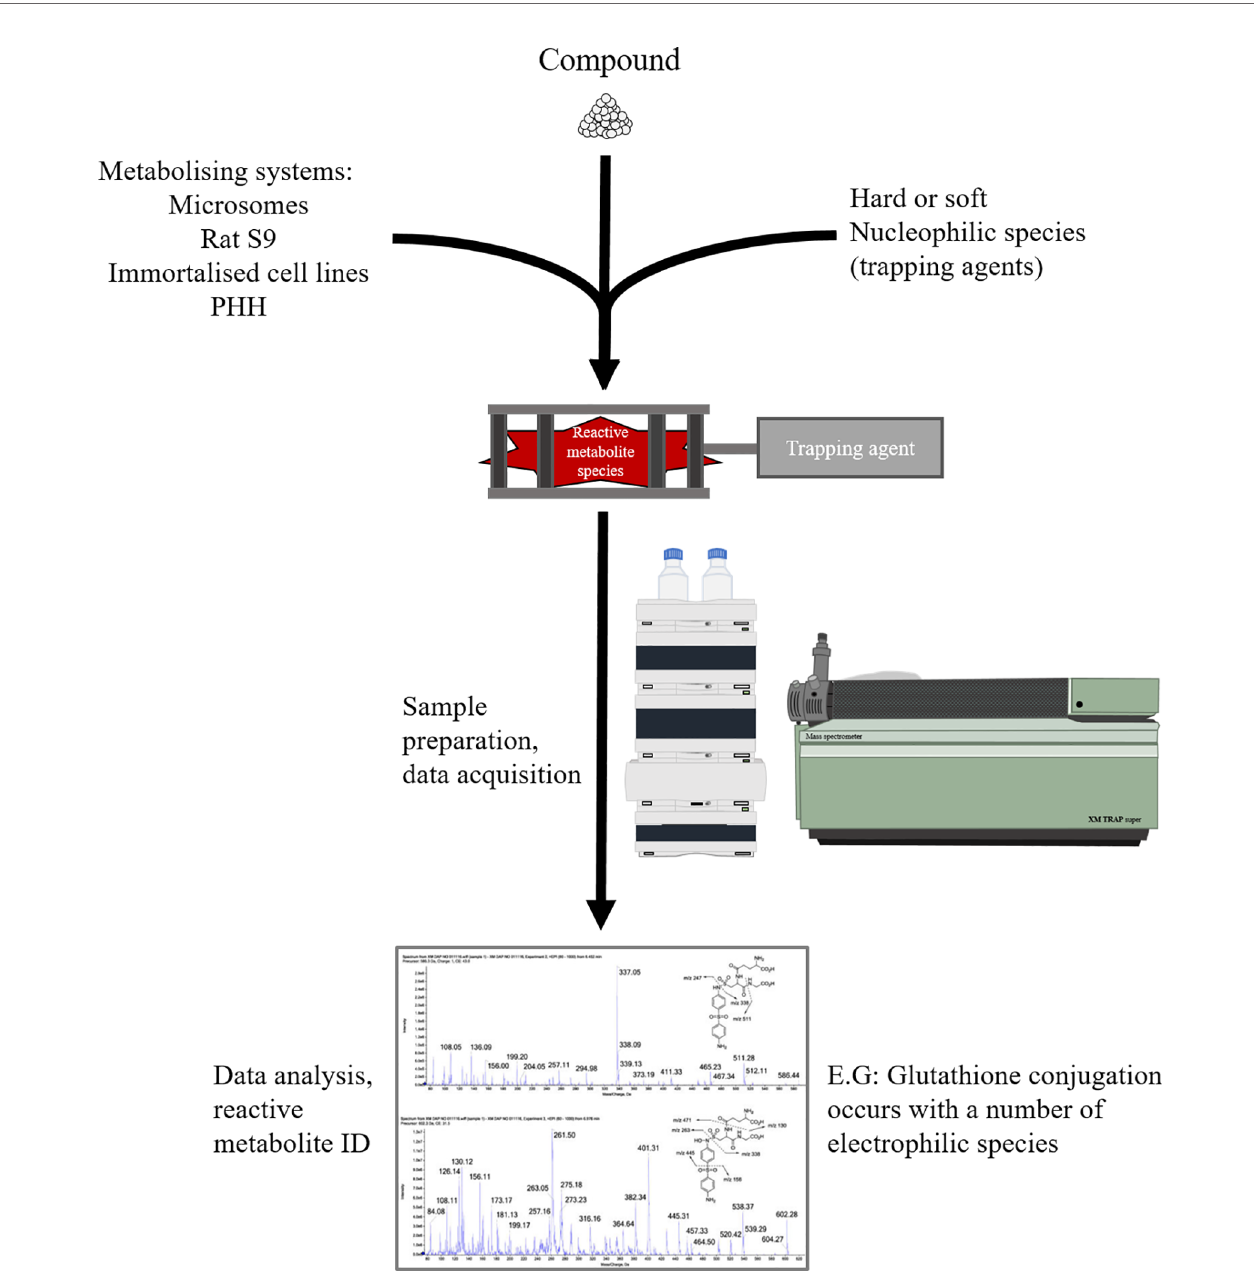
FIGURE 8 | Overview of electrophilic trapping work fl